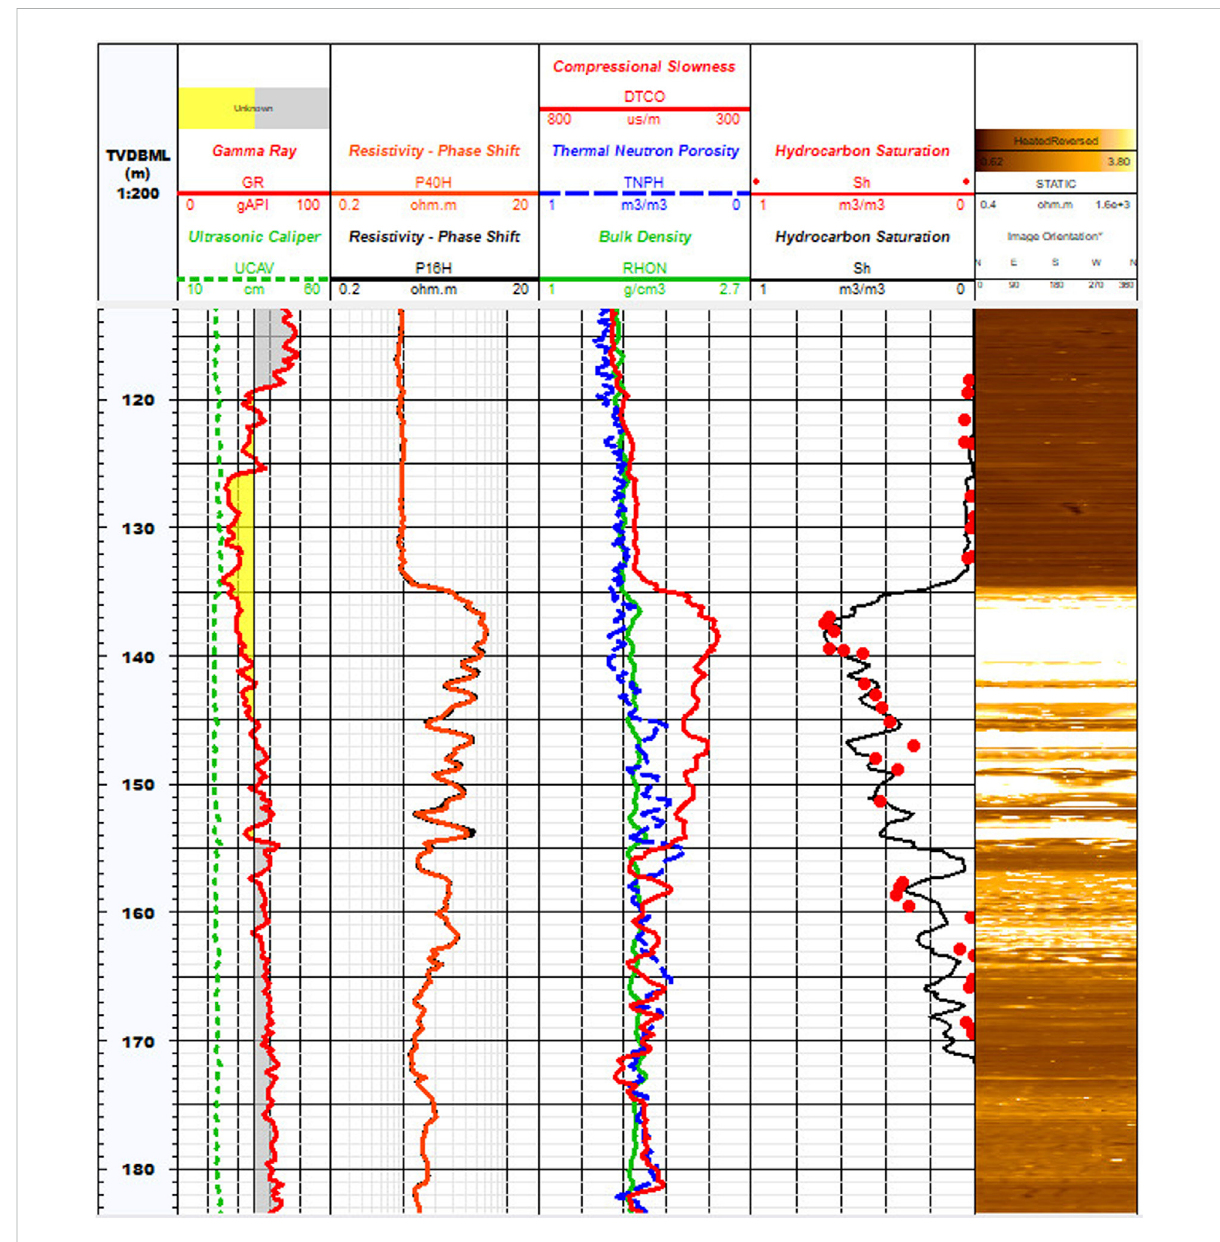
FIGURE 1 Logging map of gas hydrate reservoir of well ** in Shenhu Area, South China